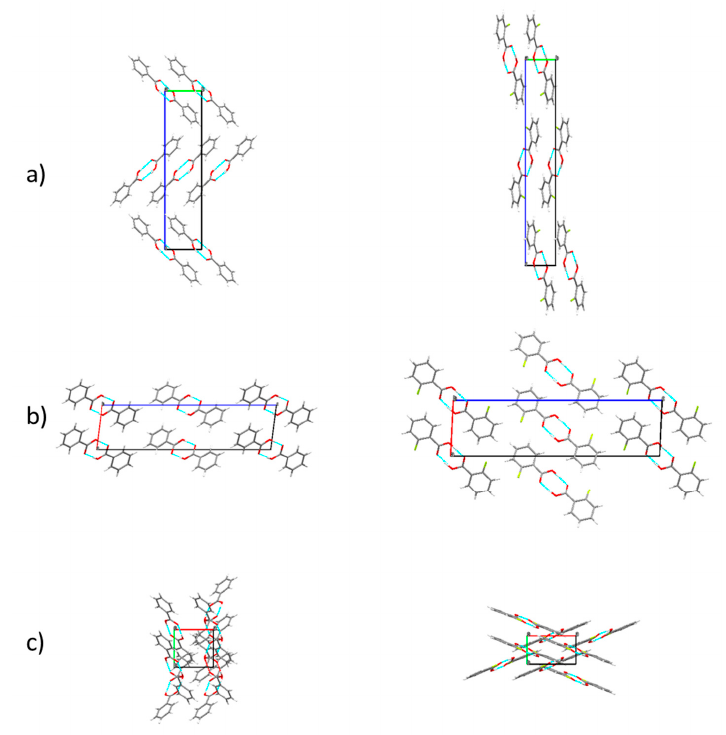
Figure 18. Crystal packing for BA ( left ) and 2FBA ( righ t) as viewed from the a ( top ), b ( middle ) and c ( bottom ) crystallographic axes. Data from Refs. [30] and [20], respectively.